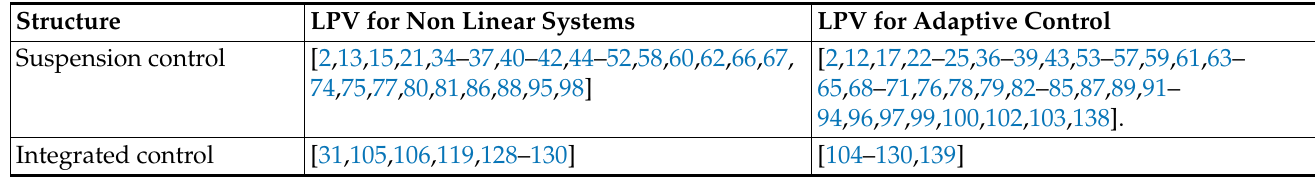
Table 2. Type of LPV methods considered for suspension and integrated